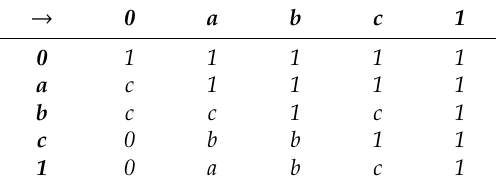
Table 2. The operation → on X .